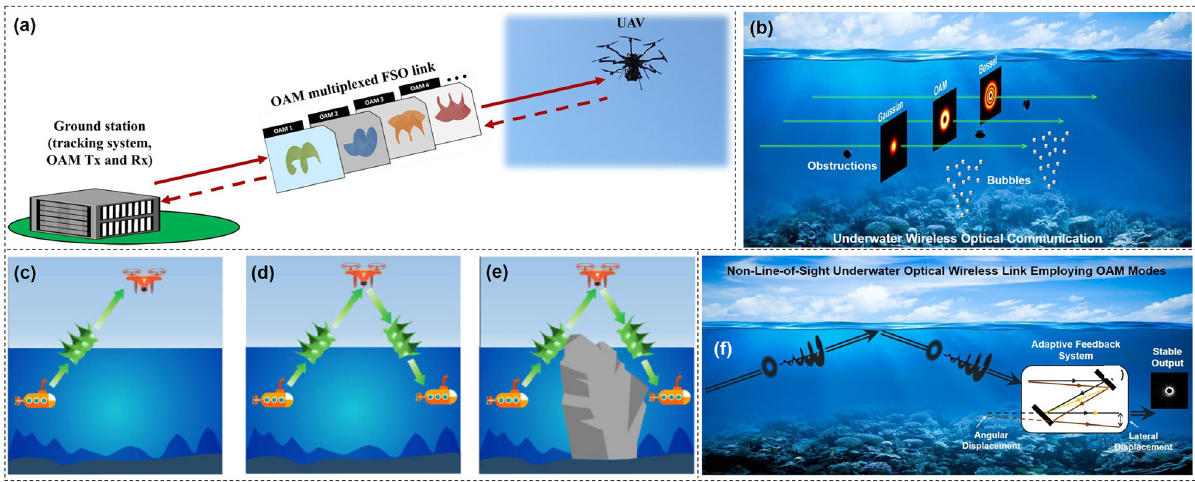
Figure 24: Diverse OAM communications in multiple